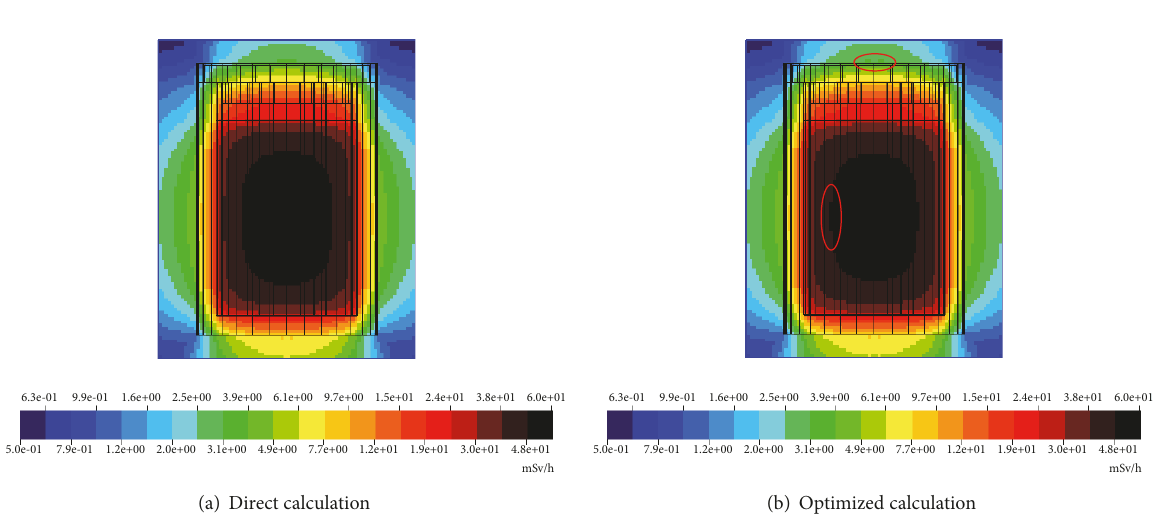
Figure 8: FLUKA-calculated 3D dose rate distribution for Case 3.